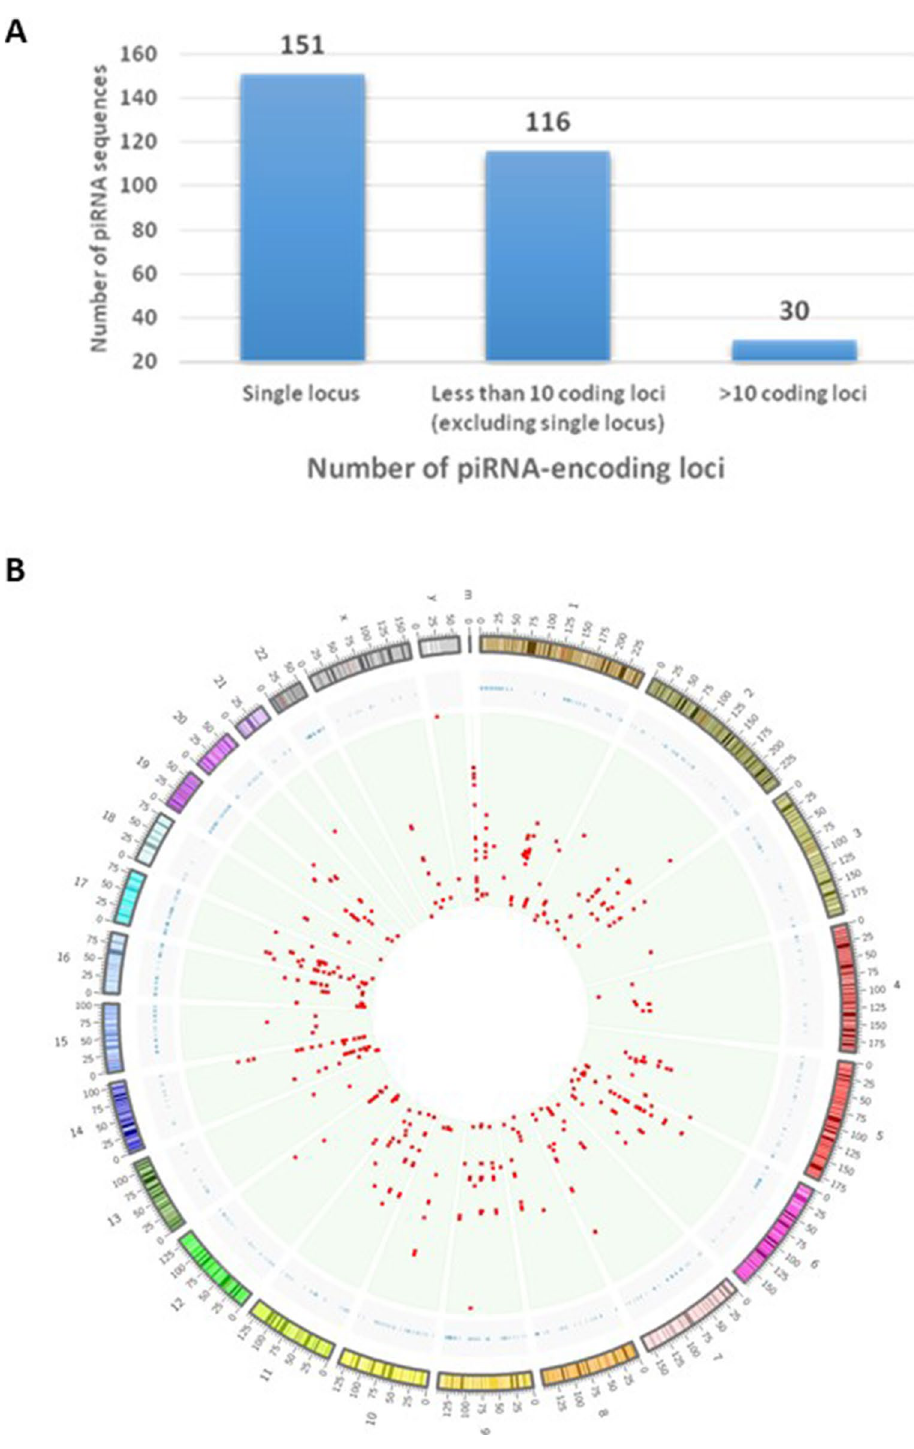
Figure 2. Genome-wide distribution of regions harbouring piRNA in the human placenta. (A) The bar graph depicts the number of piRNAs (y-axis) transcribed from 1, < 10, and > 10 genomic loci (x-axis). More than half of the piRNAs expressed in placenta (n = 151/297) are transcribed from a single locus, while 89.6% (n = 266) of the expressed sequences are transcribed from less than 10. (B) Circular representation of the human genome (circos plot) highlighting the chromosomal location of the 636 loci encoding the 297 placental-expressed piRNAs. The outer circle represents human chromosomes (1–22, X, Y and M, hg19 coordinates). The position of human piRNA clusters are shown in the concentric blue layer interior to the chromosomal positions. Each red dot in the green concentric circle represents one of the 636 piRNA